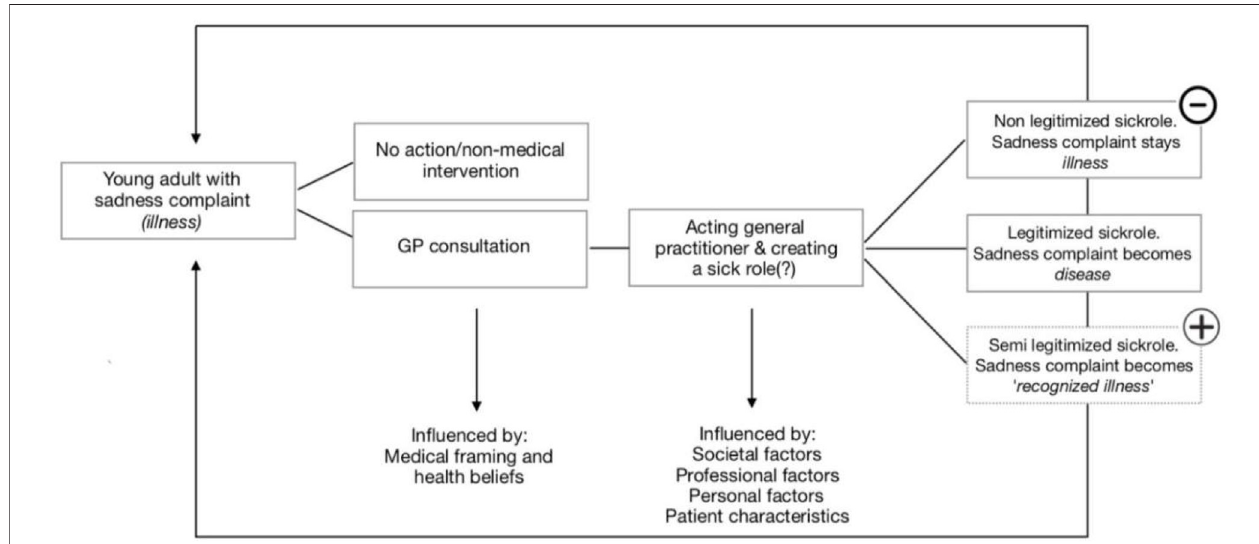
FIGURE 3 | Conceptual model with the introduced semi-legitimized sick